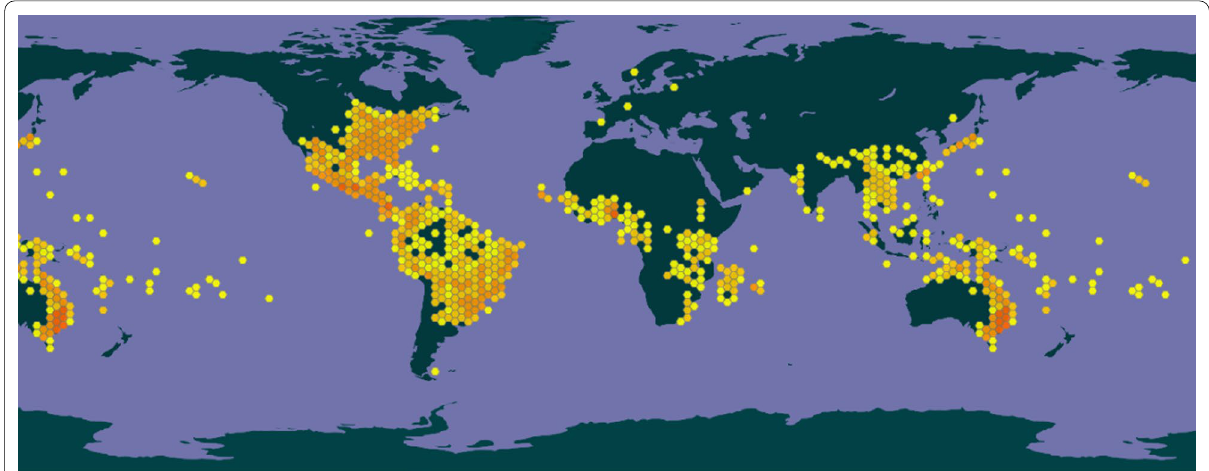
Fig. 1 Map showing the worldwide distribution of Desmodium species. Source: GBIF (https:// www. gbif. org/ speci es/ 29670